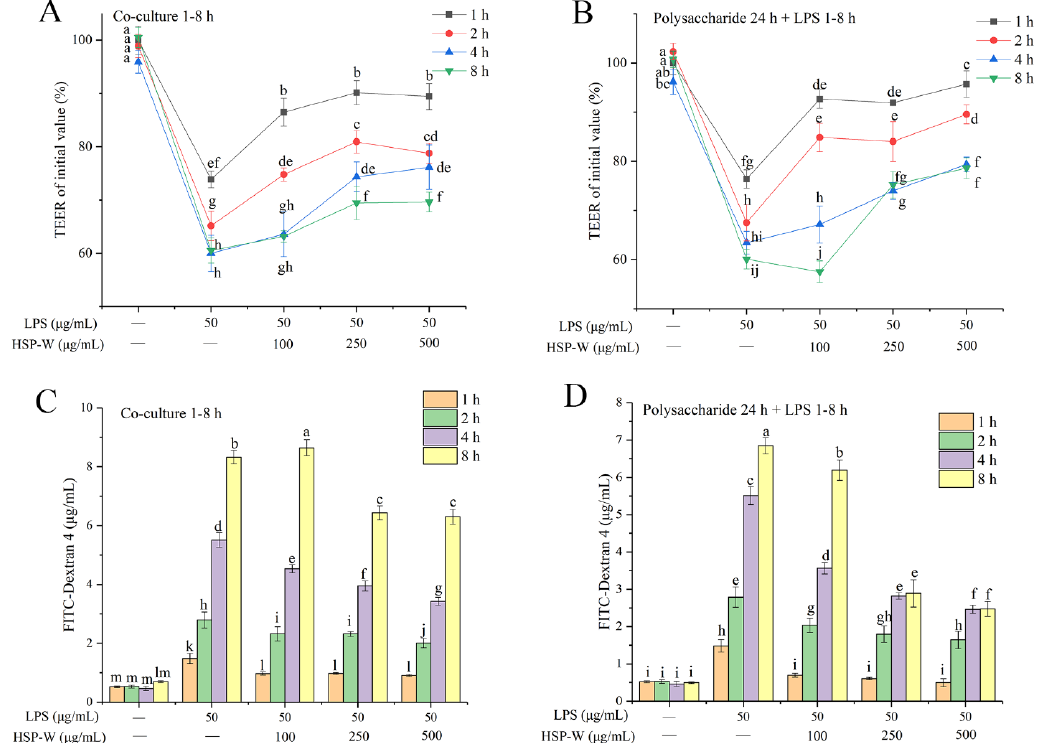
Figure 2. Effects of HSP-W on decreased TEER values and increased FD-4 fluxes caused by LPS: ( A , C ) co-culture with HSP-W for 1 – 8 h, or ( B , D ) pretreatment with HSP-W for 24 h. Data were shown as the mean ± SD from four independent experiments. Different letters represented the significant difference at p < 0.05.